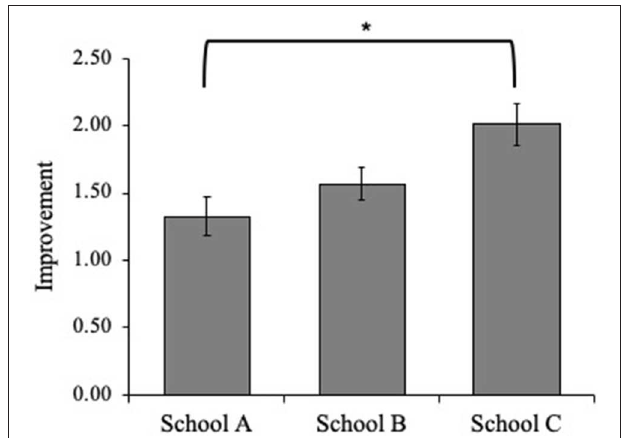
FIGURE 5 | Average improvement of 5th-grade reading fluency as a function of school. Error bars represent standard errors. *Significant difference obtained with Bonferroni pair-wise comparisons ( p < 0.05).